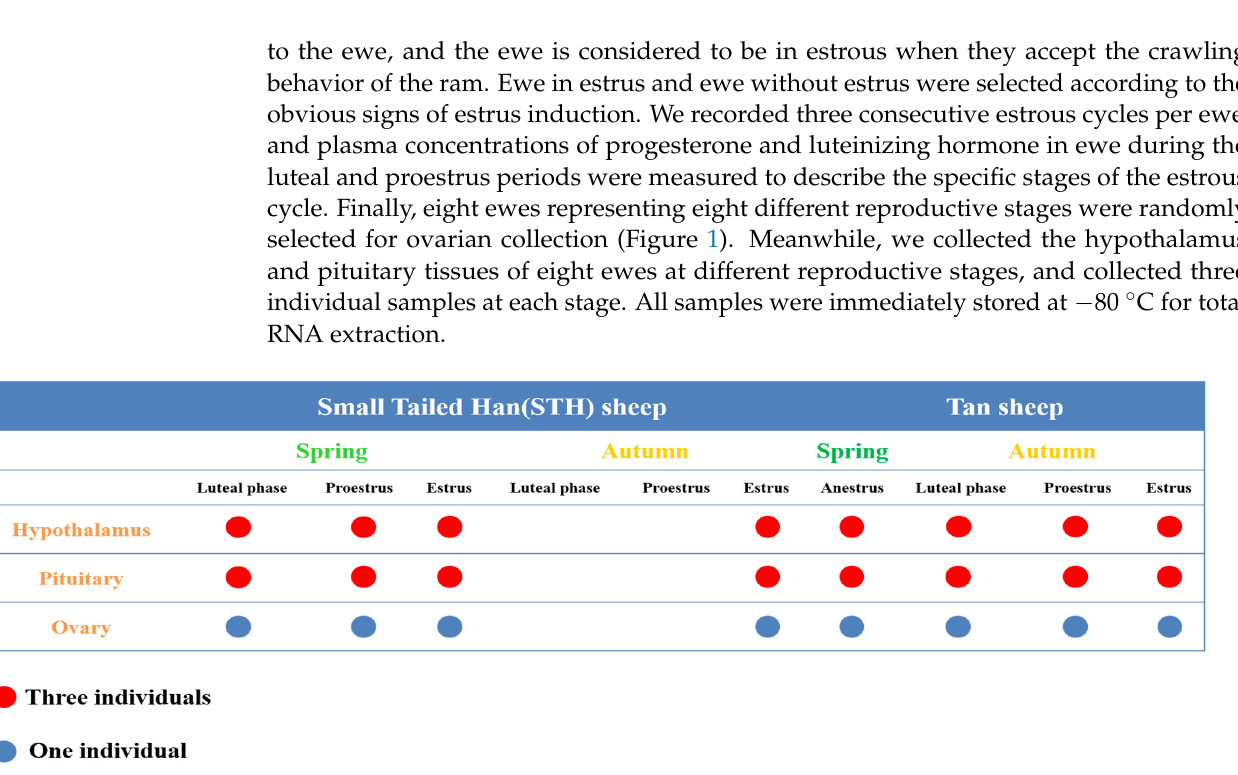
Figure 1. The number of hypothalamus, pituitary and ovary samples collected from 8 different reproductive stages. The stages including Tan ewes in spring at anestrous stages (TSA), Tan ewes in autumn at luteal phase (TAL), Tan ewes in autumn at proestrus stage (TAP), Tan ewes in autumn at estrus stage (TAE), STH ewes in spring at luteal phase (HSL), STH ewes in spring at proestrus (HSP), STH ewes in spring at estrus stage (HSE) and STH ewes in autumn at estrus stage (HAE).